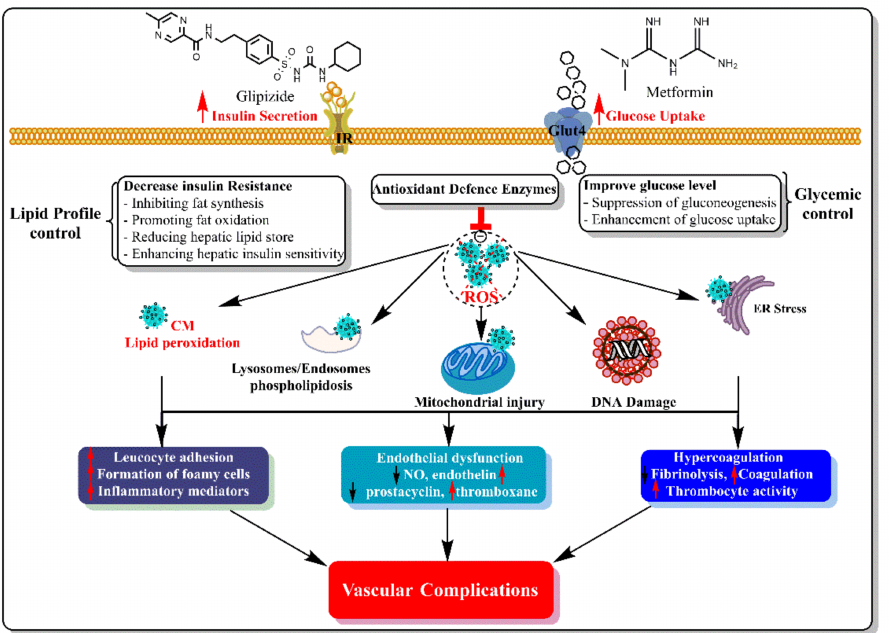
Figure 8. The synergistic interactions between metformin and Glipizide in diabetes with different targets and mechanisms of action lead to decreased oxidative stress damages and prevented vascular complications of